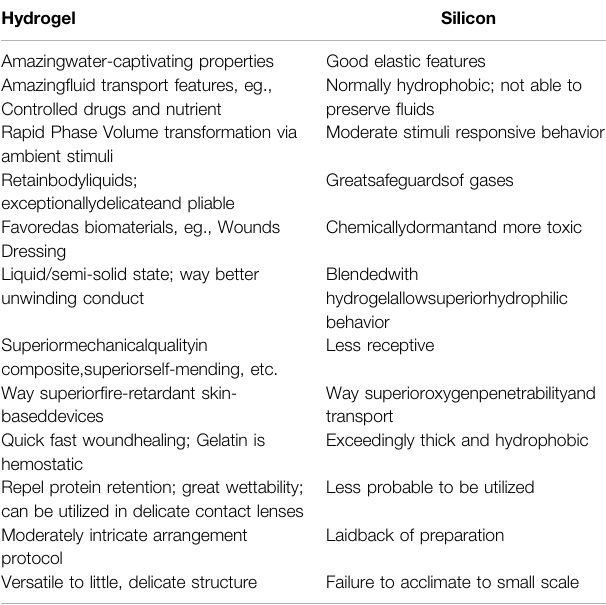
TABLE 1 | Some key differences in properties between hydrogel and silicone elastomer (2018a). Copyright 2018, Biomimetic